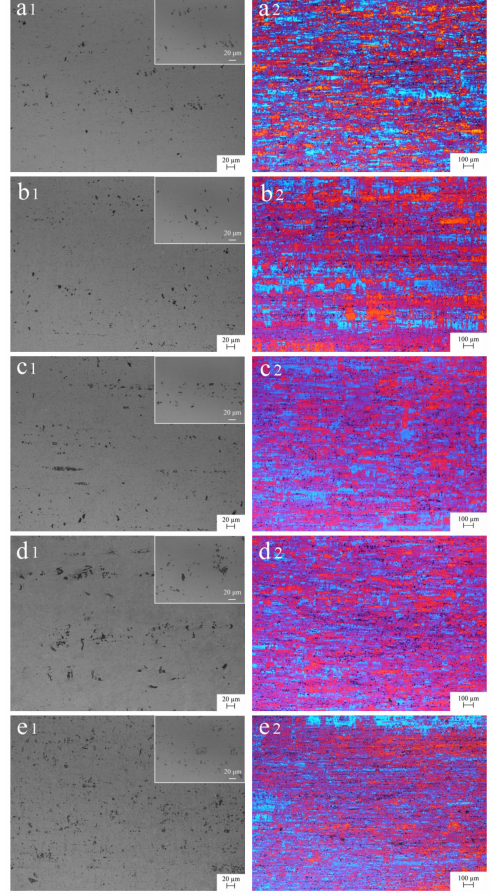
Figure 4. Metallographic structure of cold-rolled 5052 aluminum alloys with embedded graphs to reflect the local characteristics on the top right of images: ( a1 , a2 ) A0 without Er; ( b1 , b2 ) A1 with 0.1% Er; ( c1 , c2 ) A2 with 0.2% Er; ( d1 , d2 ) A3 with 0.4% Er and ( e1 , e2 ) A4 with 0.8%